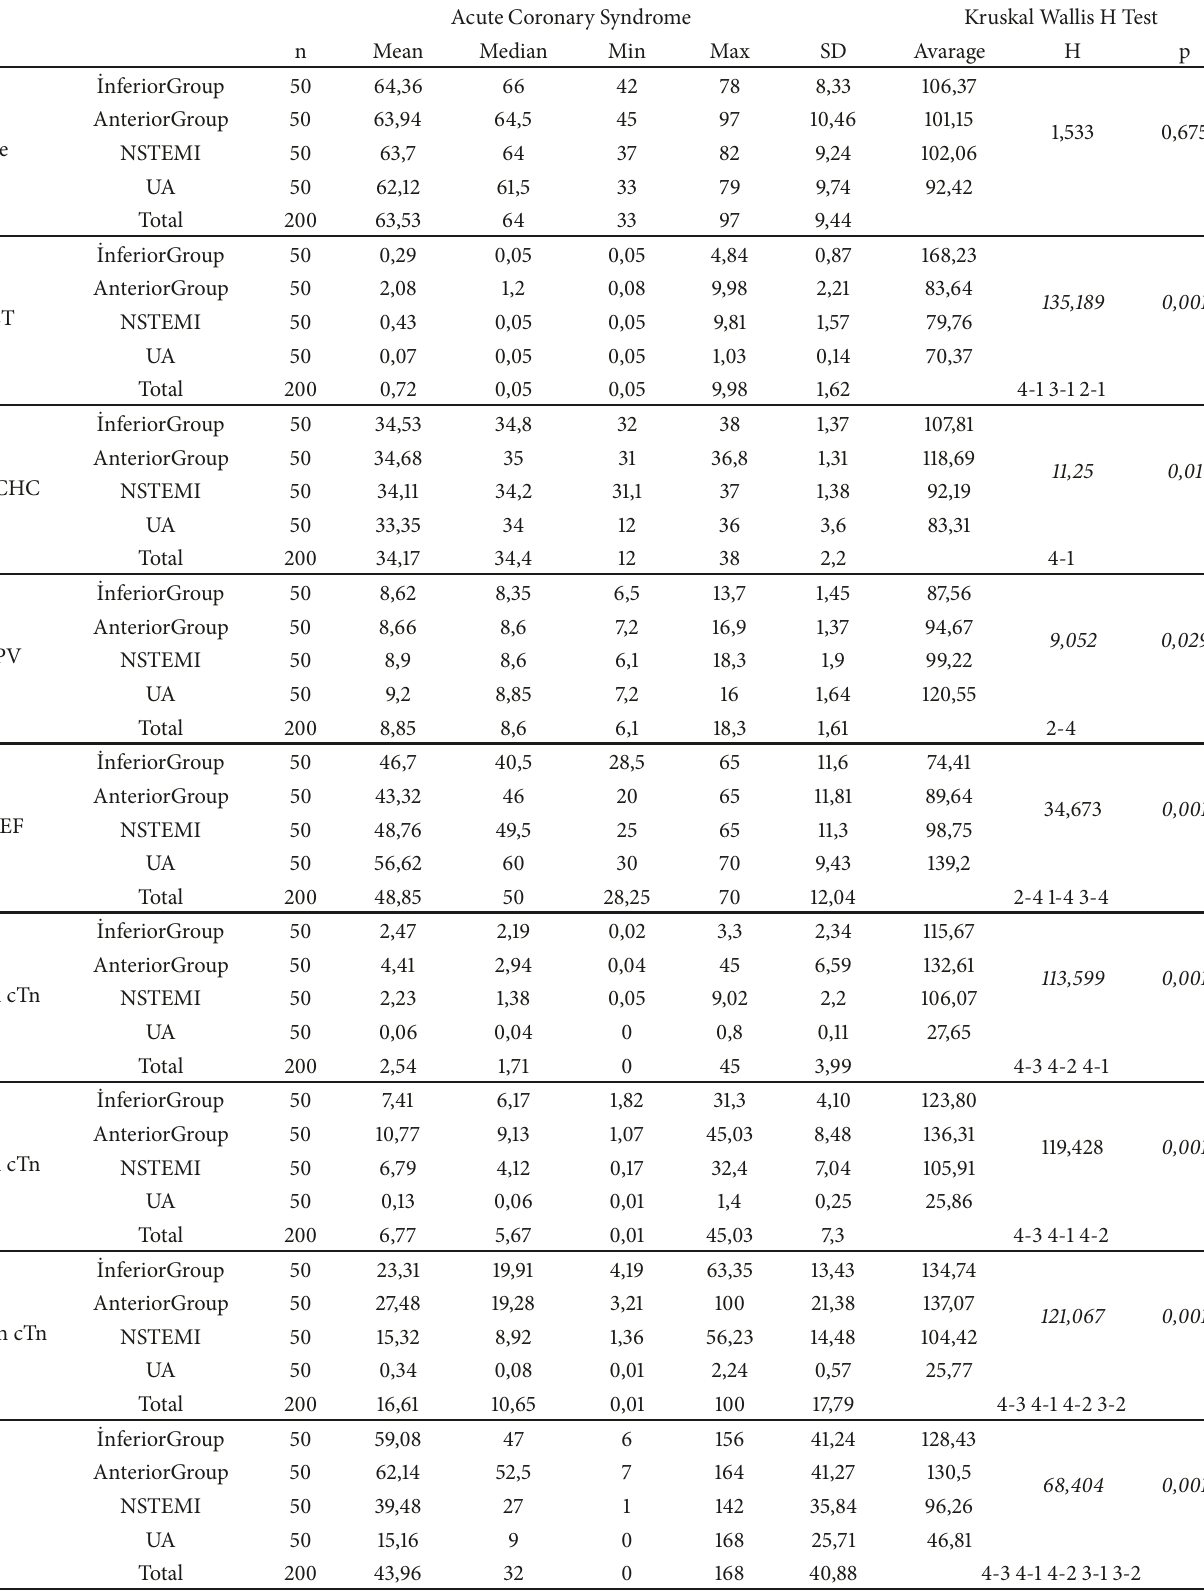
Table 3: Kruskal Wallis H Test Result Related to the difference between ACS groups in terms of